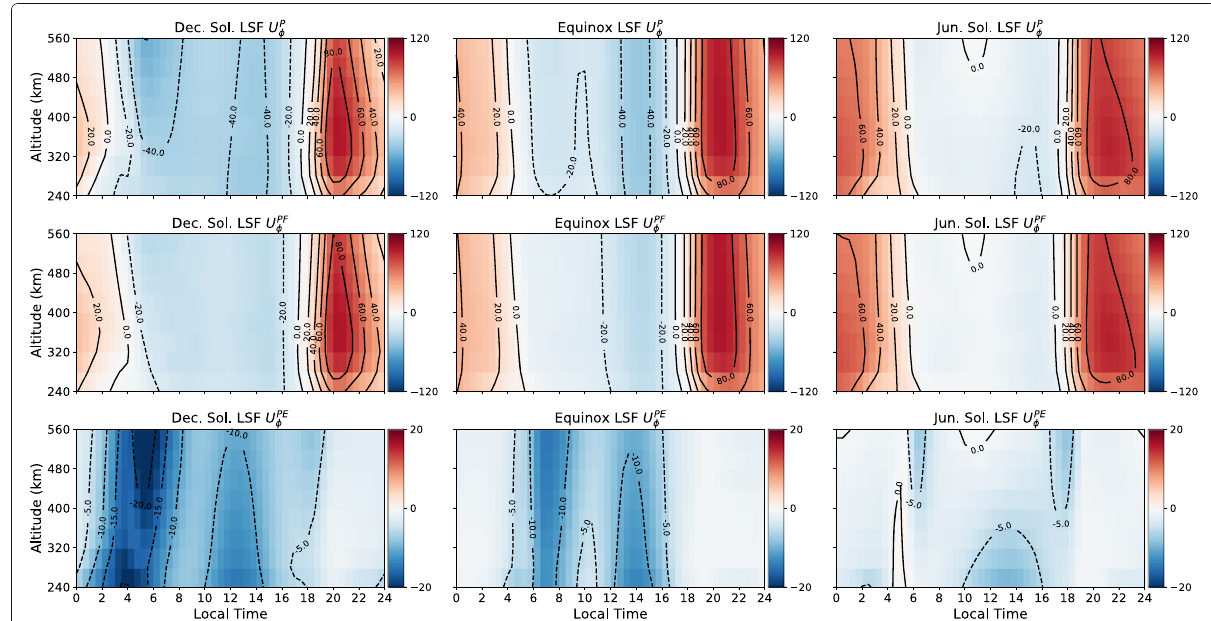
Fig. 11 The contributions from the E and F regions to the zonal wind dynamo during low solar flux (LSF) conditions. HWM14 was used to drive the zonal drift model